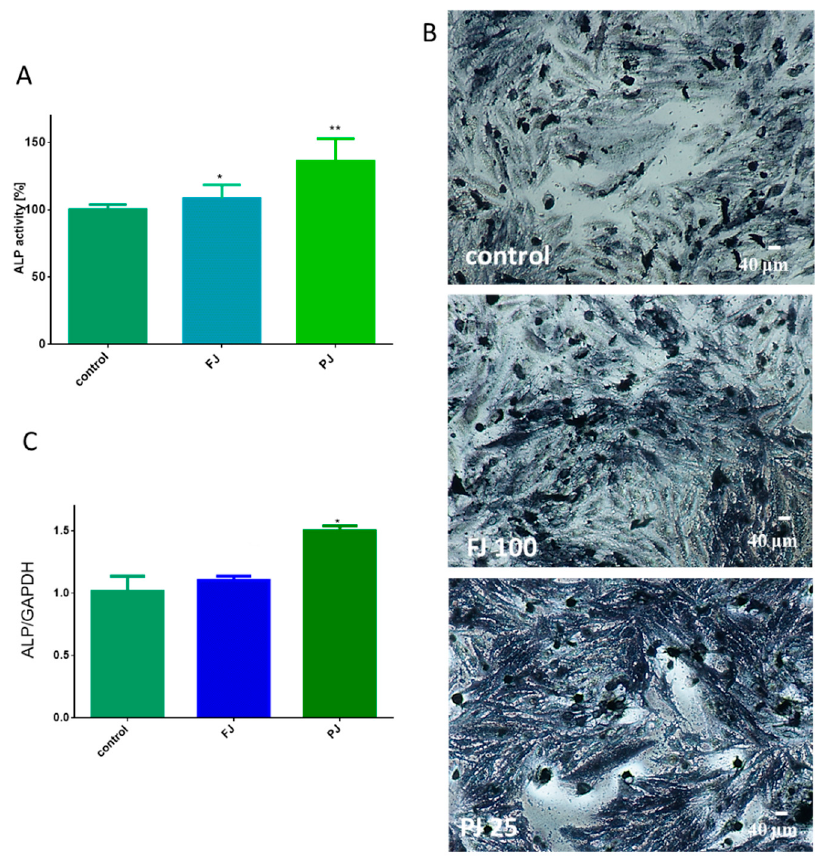
Figure 4. The influence of V. opulus FJ and PJ at IC 0 dosage on Saos-2 cell alkaline phosphatase (ALP) activity, determined with pNPP assay after 8 days of exposure ( A ); control cells were not exposed to any compound; values are means ± SEM, n ≥ 12. Cells observed in the presence of BCIP / NBT, known substrate for ALP, after their incubation with 100 µ g / mL FJ and 25 µ g / mL PJ ( B ); randomly chosen fields were photographed at × 400 with contrast-phase microscope. The expression of mRNA level of ALP gene quantified by real-time PCR and normalized using glyceraldehyde-3-phosphate dehydrogenase ( GAPDH ) as a reference gene ( n = 4) ( C ). Statistical significance was calculated versus control cells (untreated), * p ≥ 0.05, ** p ≥ 0.01.